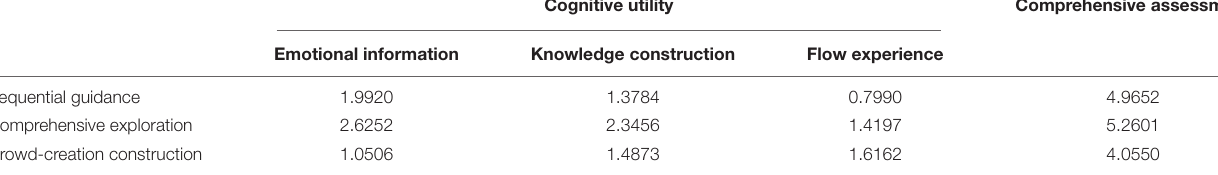
TABLE 3 | Cognitive utility.